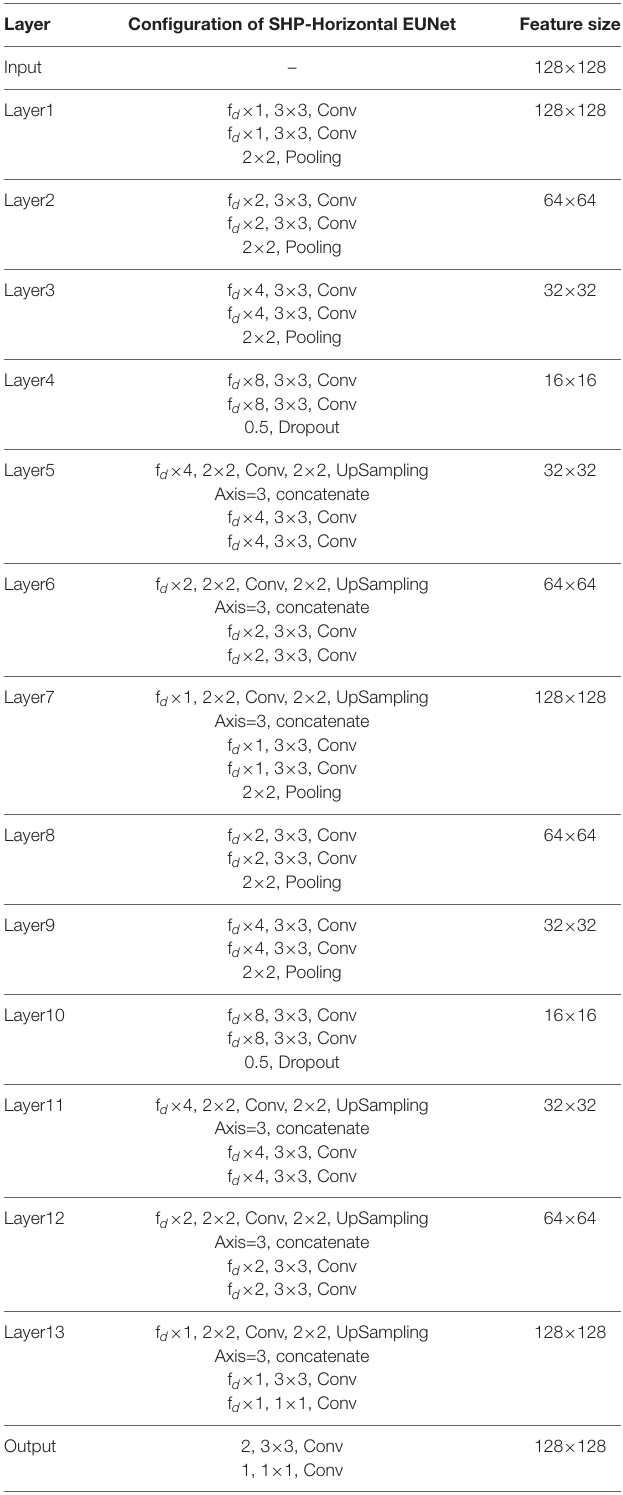
TABLE 1 | Architecture and parameters of single high peak horizontal elastomeric U-Net (SHP-horizontal